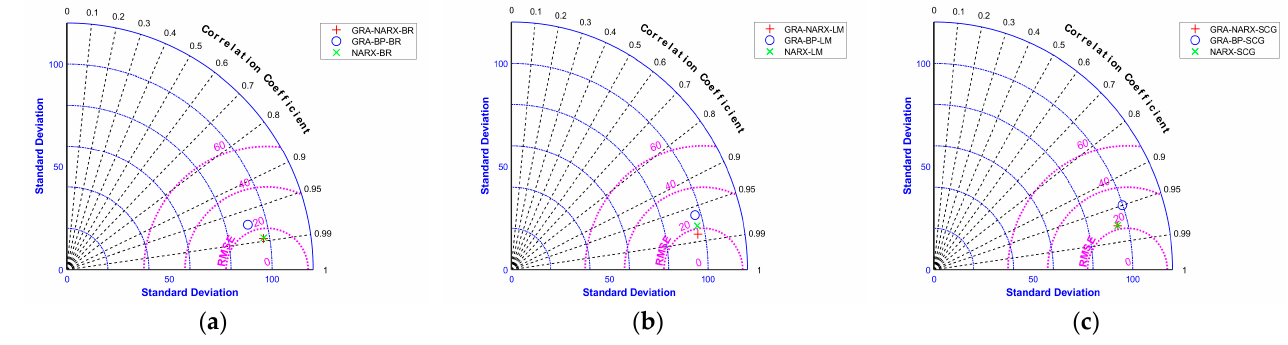
Figure 12. Taylor plots of measured and predicted water levels: ( a ) use of BR as the training algorithm, ( b ) use of BR as the training algorithm, and ( c ) use of BR as the training algorithm.